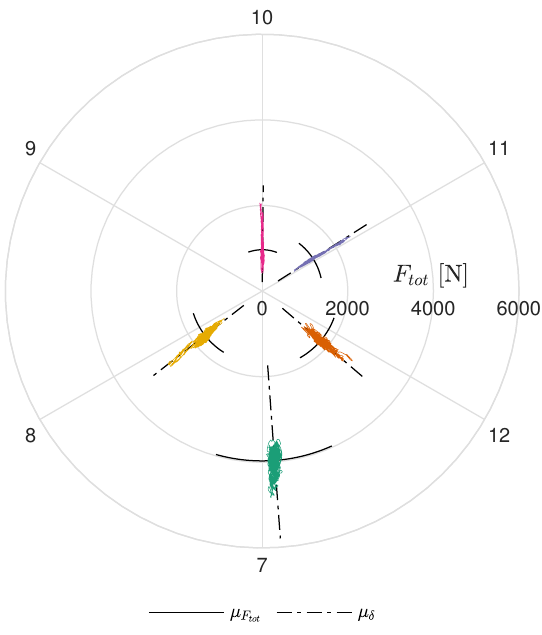
Figure 13: Plot showing forces F tot on panel 145 carrying return rollers, together with the mean force µ F